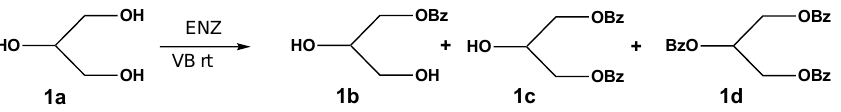
Figure 2. General reaction and products of enzymatic benzoylation used as standards for GC analysis. (Enzyme (ENZ), Room Temperature (rt)).